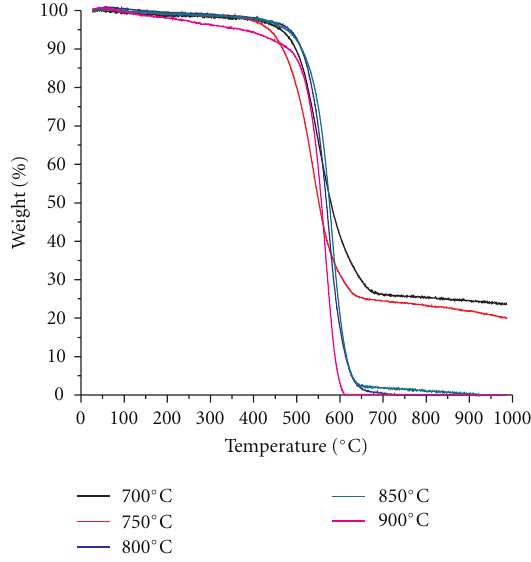
Figure 6: Graph showing thermal stability of aligned CNT at di ff erent synthesis